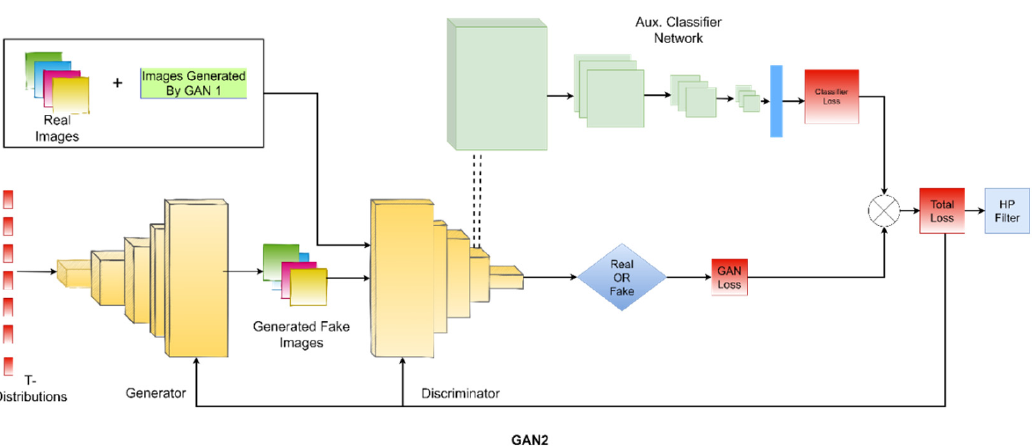
Figure 2. The generative adversarial network, GAN 2 , of the proposed framework and the auxiliary classifier. GAN 2 samples the input noise vector from student t-distribution and uses the images generated by GAN 1 for training. Generated images are passed through a high pass filter to improve imperceptibility.